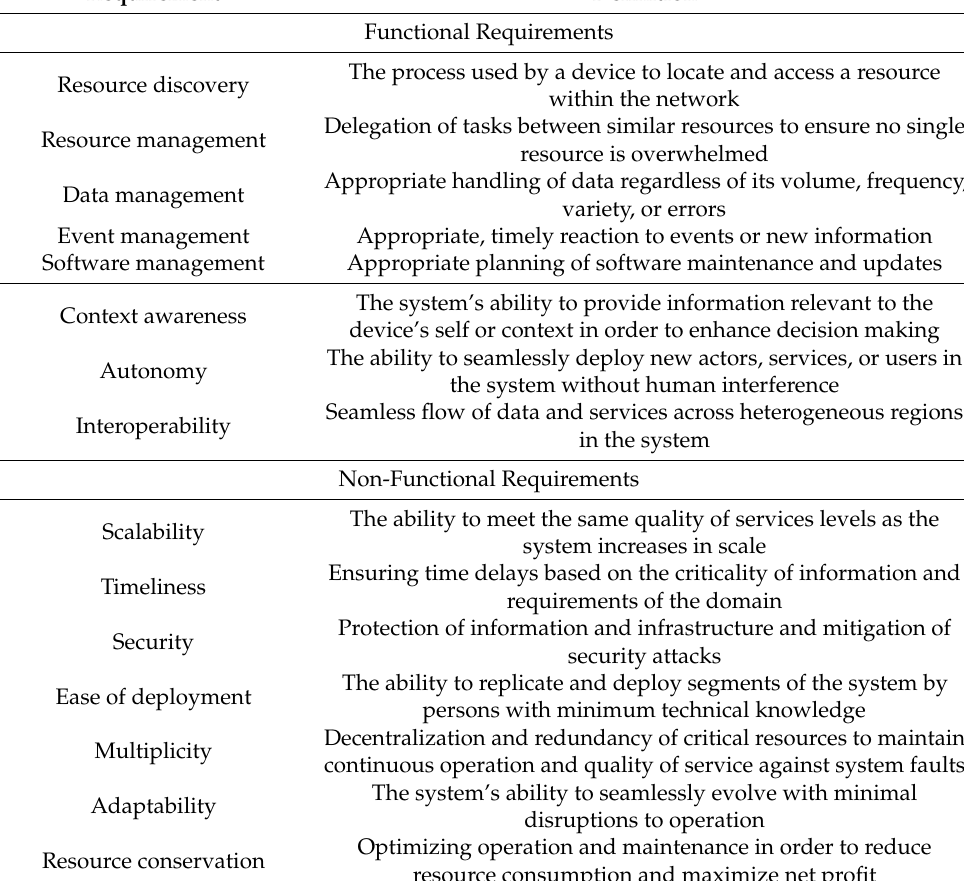
Table 1. System functional and non-functional